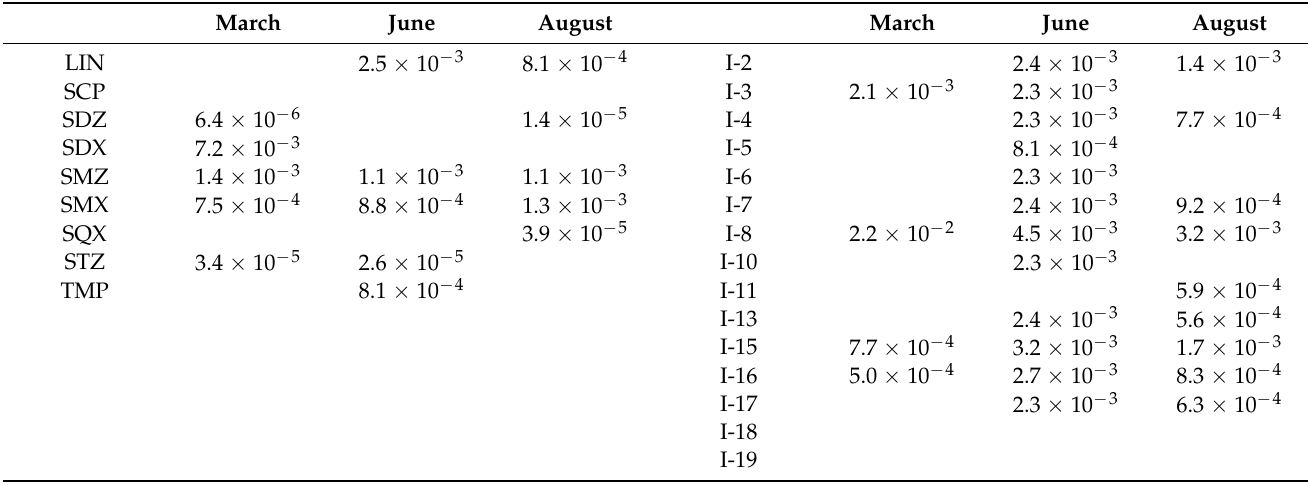
Table A8. Risk assessment for resistance to antibiotics in the groundwater samples. Blank cells indicate samples where no antibiotic could be